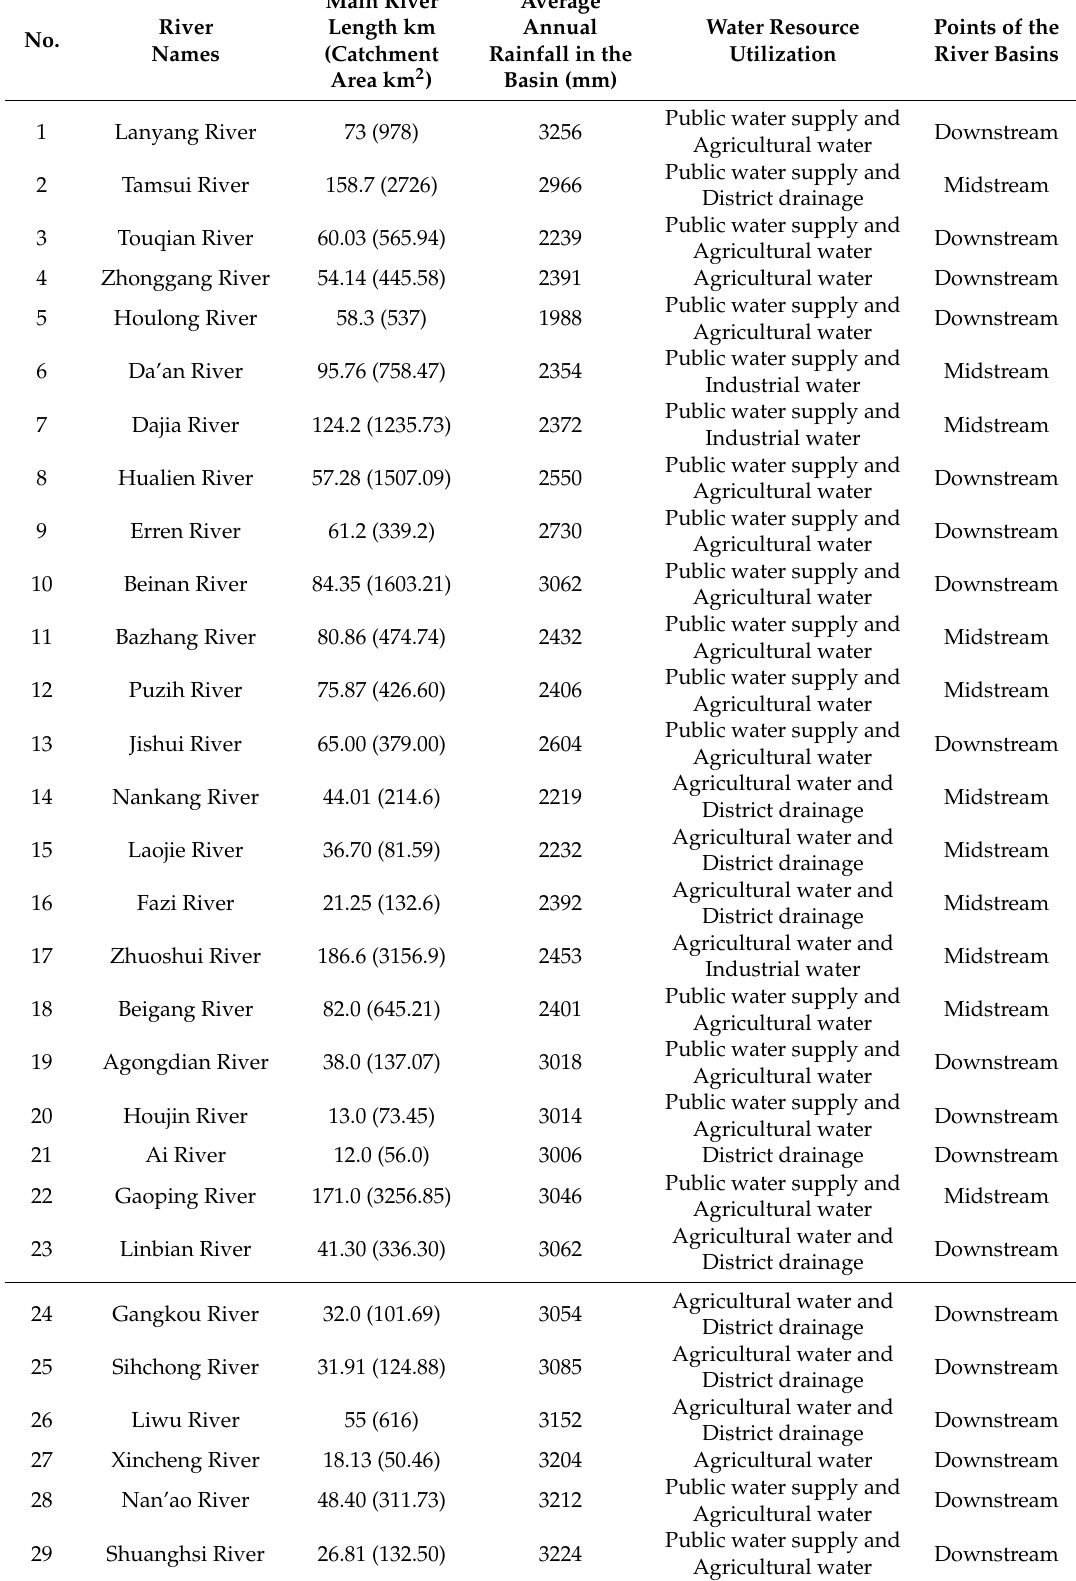
Table 1. Information about the rivers within the investigation